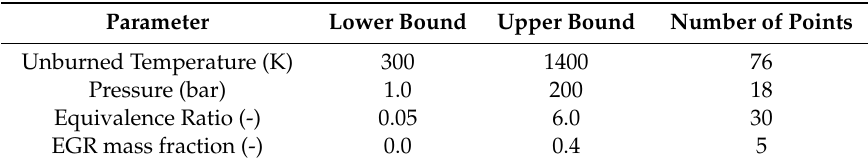
Table 1. Tabulation grid adopted for all tabulated chemistry